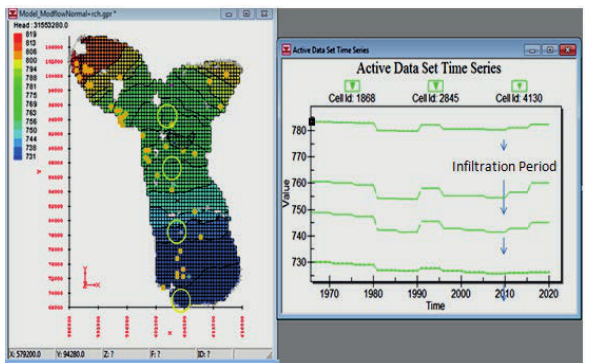
Fig. 3 Numerical simulation of aquifer artificial recharge in Tafilalet aquifer,